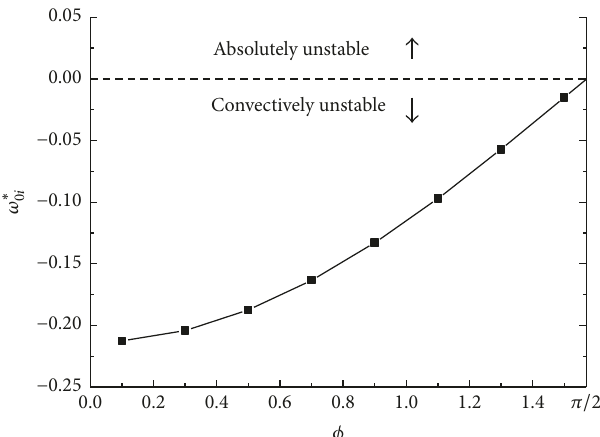
Figure 5: The variation of absolute growth rate with oblique angle 𝜙 ( Λ = 1 , 𝑀 = 0 , 𝑆 = 2 ). 𝑇